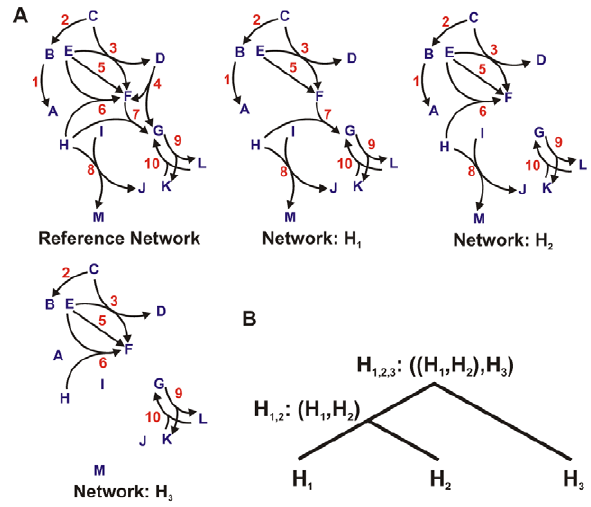
Figure 1. Toy networks connected by a phylogeny. (A) Toy networks consisting of 13 nodes. The nodes are labeled from A to M (blue) and the hyperedges are labeled from 1 to 10 (red). The reference network consists of all allowed hyperedges for this example system. Networks H 1 , H 2 and H 3 consist of subsets of the hyperedges from the reference network. (B) A phylogeny connecting the networks H 1 , H 2 and H 3 .